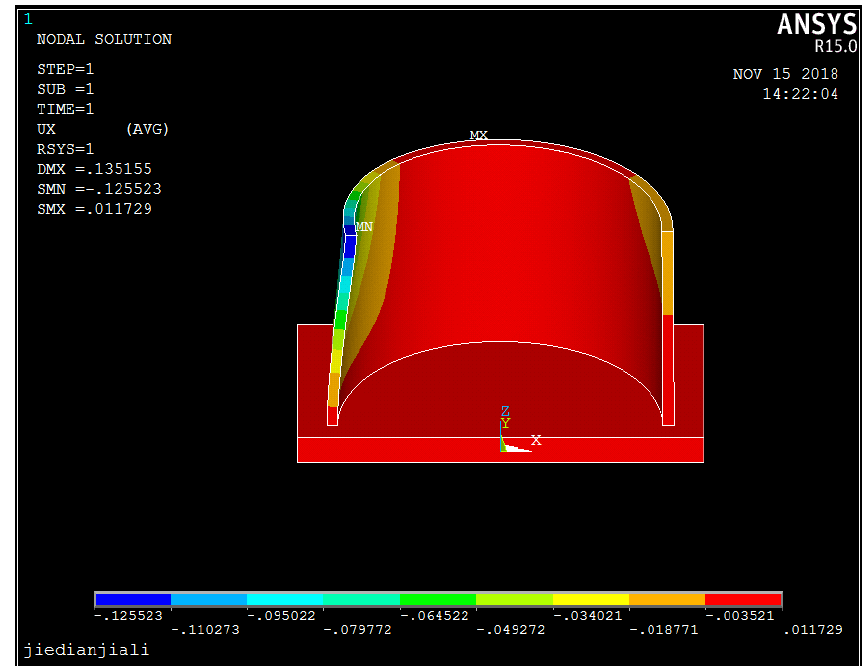
Figure 4. R direction deformation at the maximum deformation point.